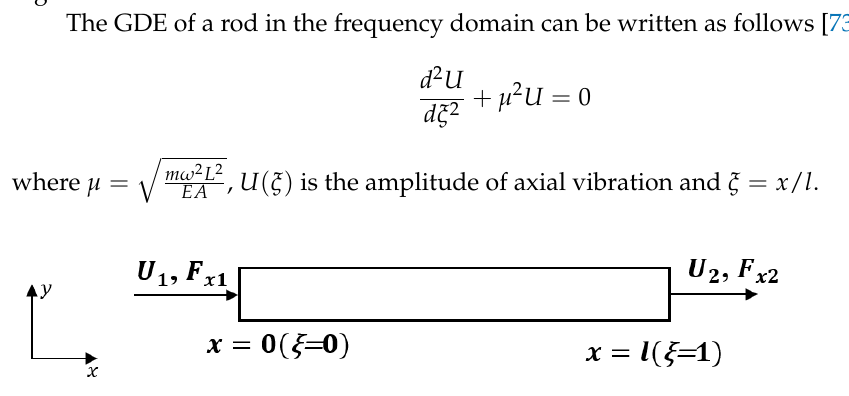
Figure 3. Amplitude of displacement and forces in axial vibration of a rod.